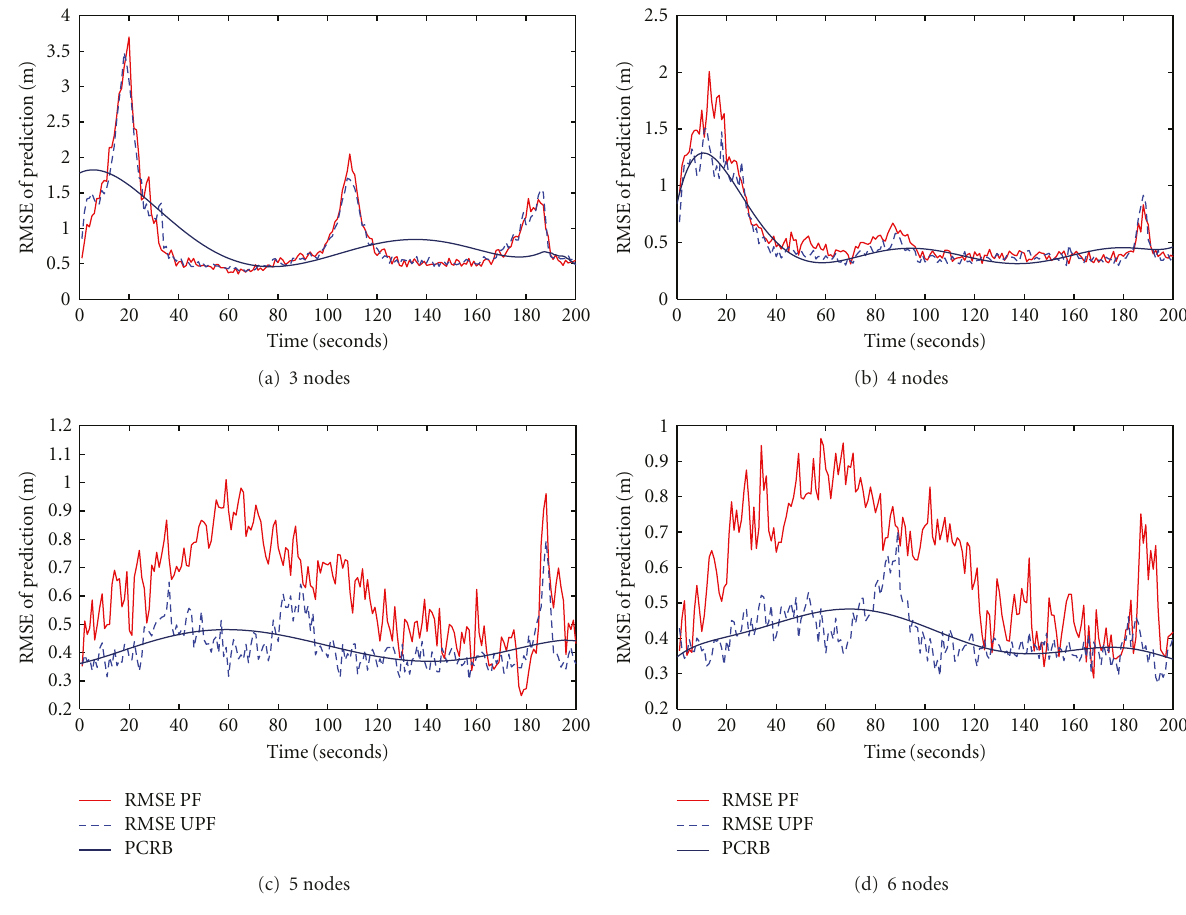
Figure 5: Compared tracking error versus time with target velocity = 0.3m/s.